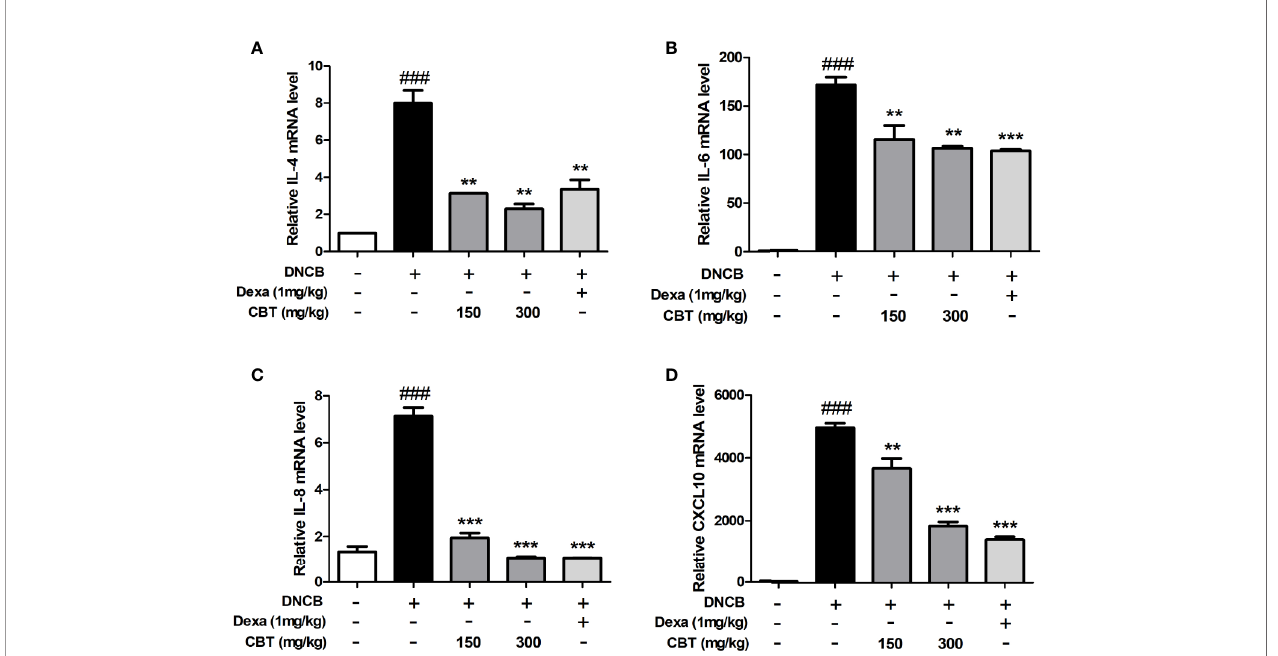
FIGURE 5 | Effects of Chijabyukpi-tang (CBT) on the mRNA expression levels of pro-in fl ammatory cytokines and chemokines in 2,4-dinitrochlorobenzene (DNCB)- treated mice skin tissues. The mRNA expression levels of IL-4 (A) , IL-6 (B) , IL-8 (C) , and CXCL10 (D) were analyzed using the quantitative real-time polymerase chain reaction (qPCR). Data are shown as mean ± SEM of the three independent experiments. ### p < 0.001 compared with the control group, **p < 0.01, and ***p < 0.001 compared with the DNCB-induced group. The Dexa group was set as positive control.